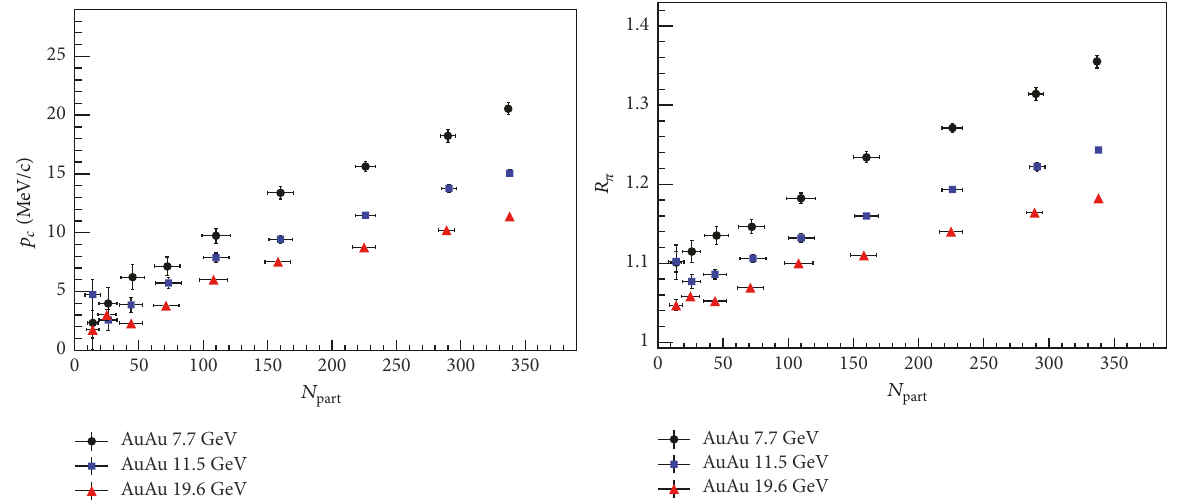
Figure 5: The Coulomb kick and initial pion ratio as a function of collision centrality and energy.